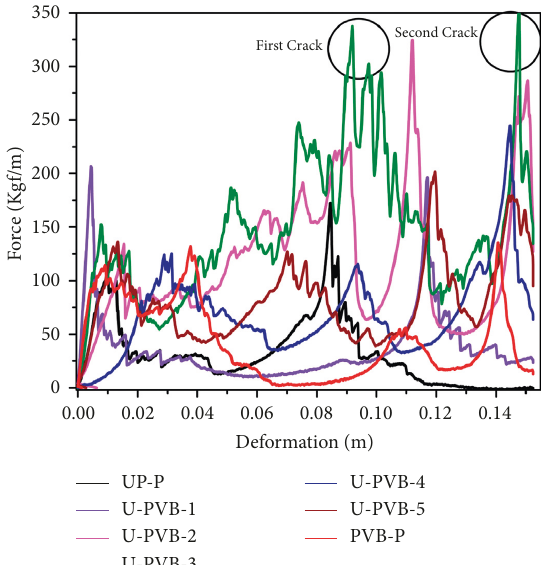
Figure 9: Different curves of standard force versus strain of de- lamination test of different samples with different PVB content.